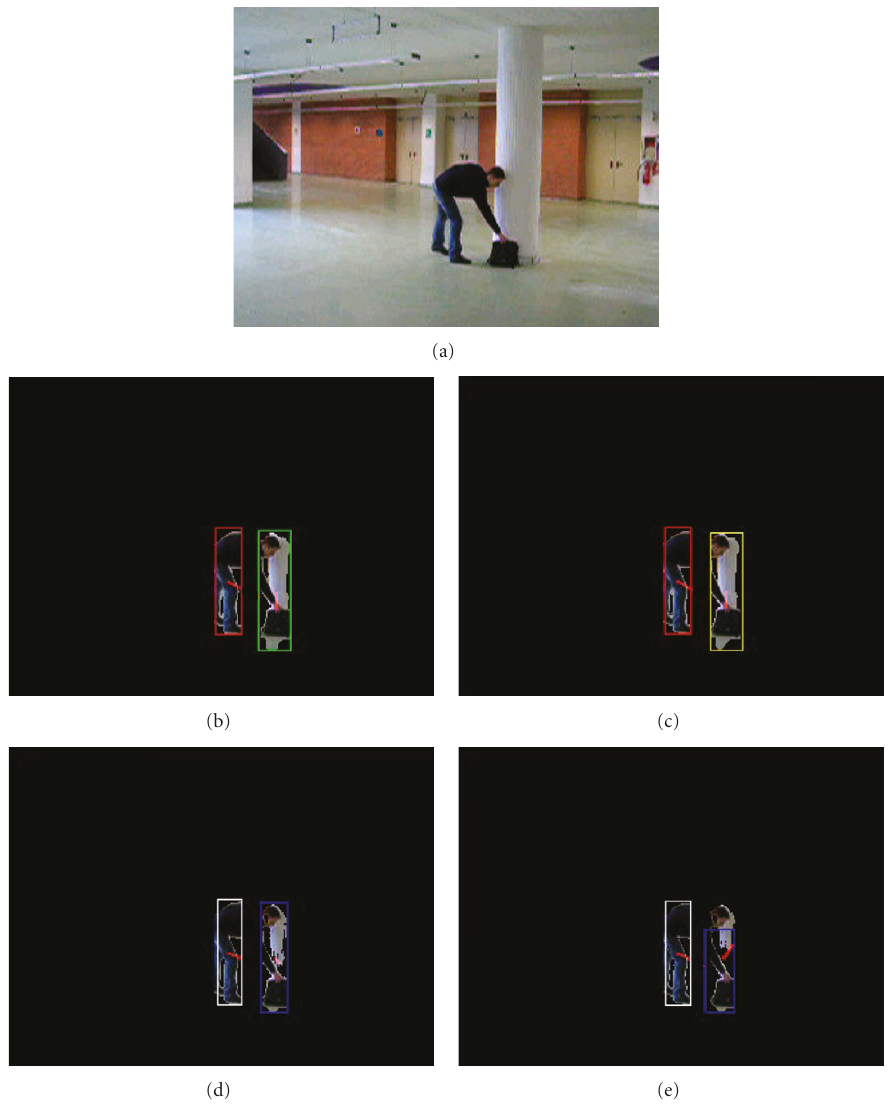
Figure 5: Examples of the output of the foreground detection on the MSA dataset; (a) Original Image; (b) EBS Algorithm; (c) MOG Algorithm; (d) SOBS Algorithm; (e) SBA